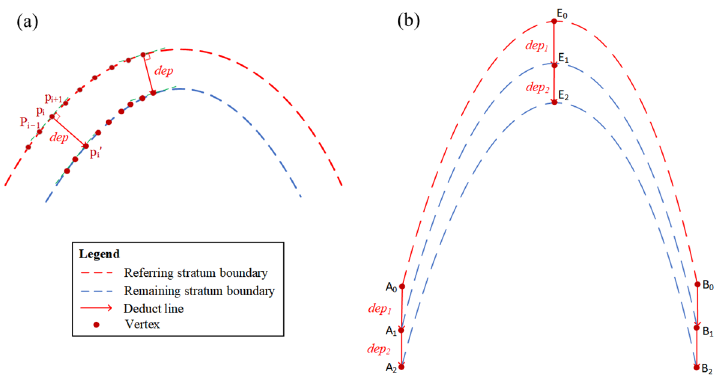
Figure 6. Deduction of general stratum boundaries: ( a ) isopach fold and ( b ) similar fold.